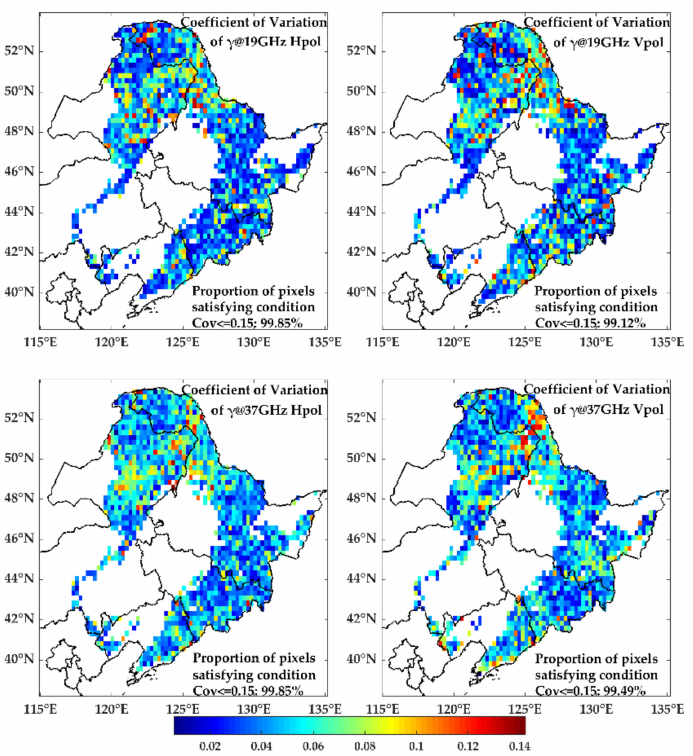
Figure 7. Spatial distribution of interannual Cov of transmissivity estimation